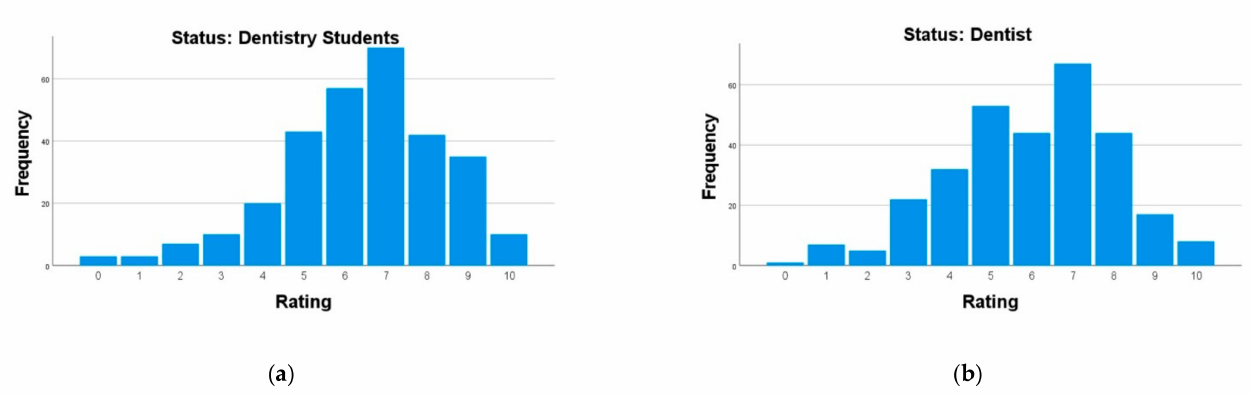
Figure 3. Evaluation of ( a ) dental students and ( b ) dentists.